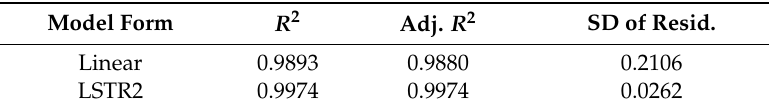
Table 9. Comparison between linear model and nonlinear model.